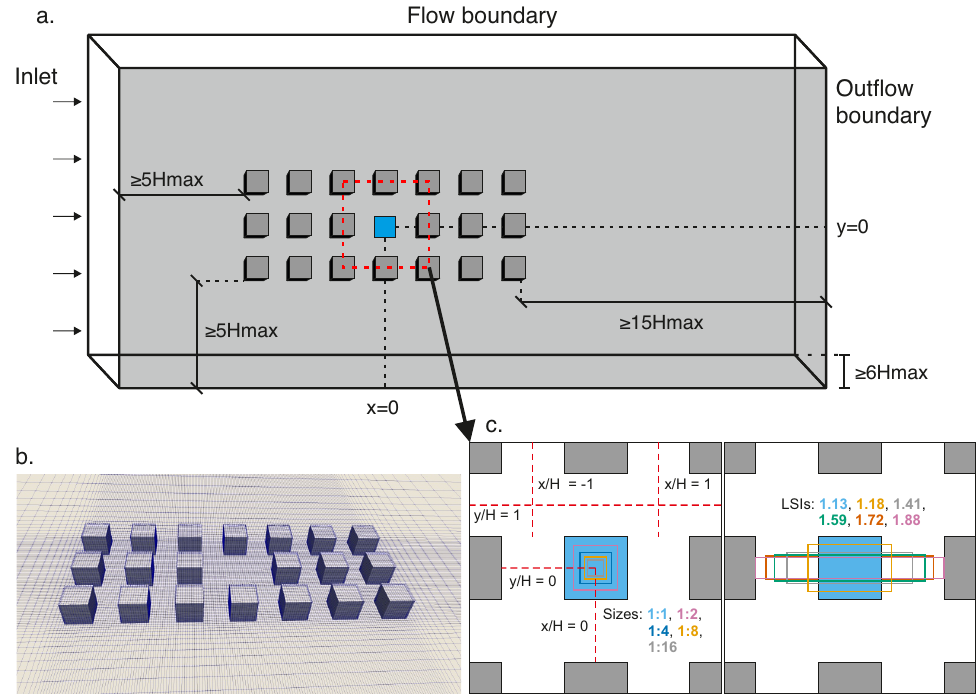
Figure 1. Overview of the case study geometry and computational grid: ( a ) schematic representation of the case geometry; ( b ) sketch of the computational grid; ( c ) sampling lines used for the analysis of the